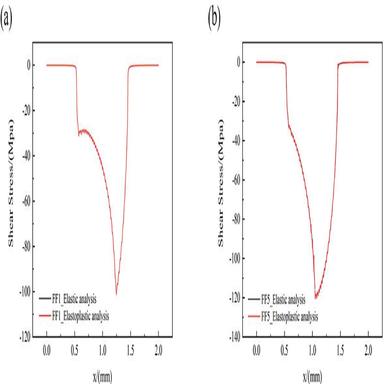
Comparison of shear stress in FF tests between the elastic analysis and the elastoplastic analysis: (a) Test No. 1 and (b) Test No. 5.